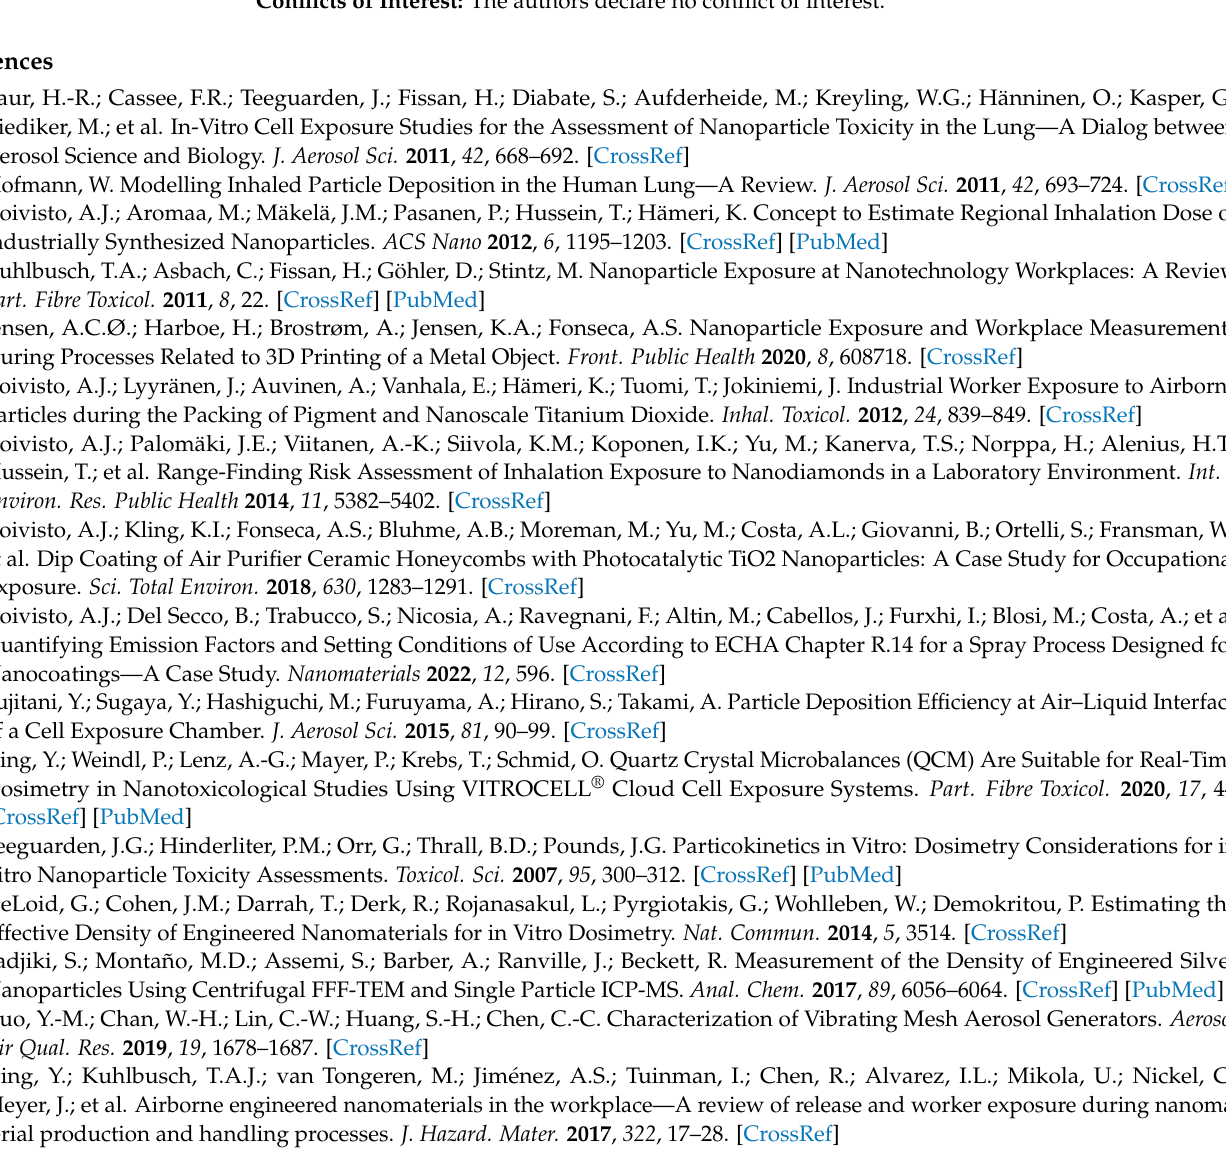
(Table S3); right: TiO 2 N particles, from test 1-2-3 (Table S3). References [25,36–40] are cited in the supplementary